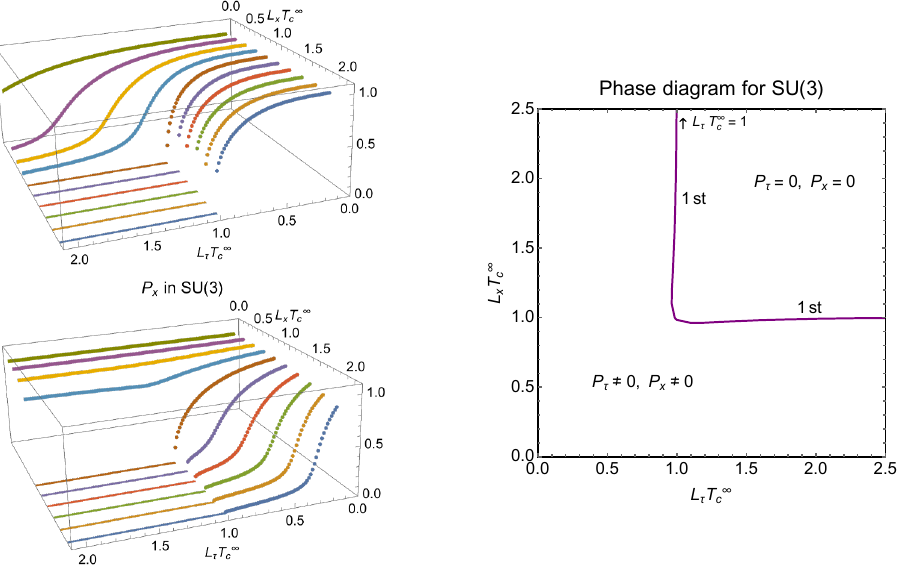
Figure 2. L τ and L x dependence of P τ (upper-left panel) and P x (lower-left panel) for N = 3. The right panel represents the corresponding phase diagram on L τ - L x plane. The detail is provided in the main